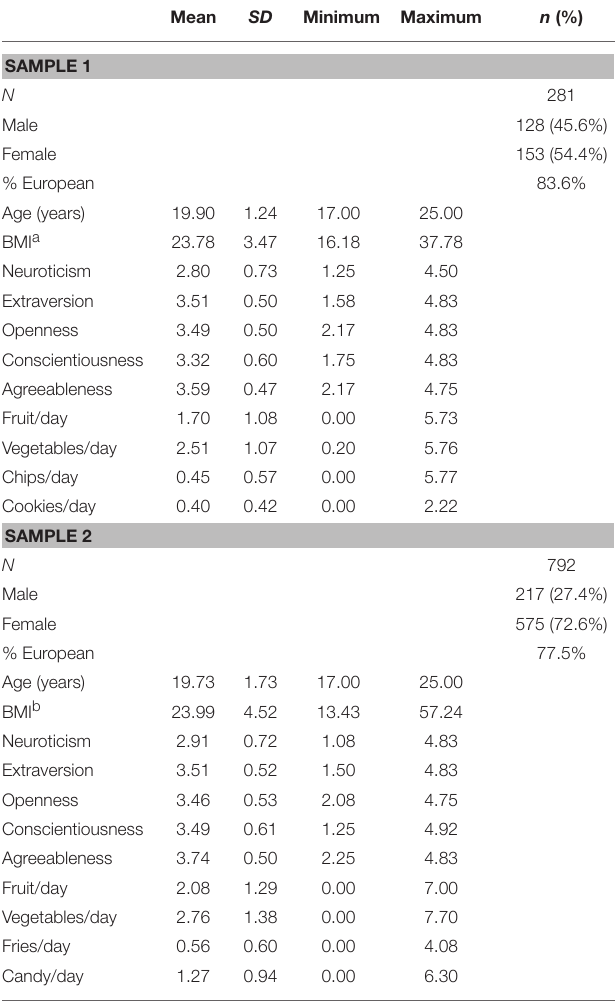
TABLE 1 | Participant characteristics and descriptive statistics for the two samples of young